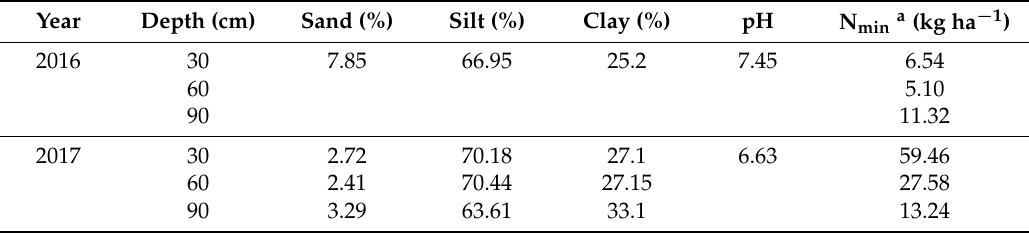
Table 1. Soil characteristics of the experimental site at Ihinger Hof in 2016 and 2017.